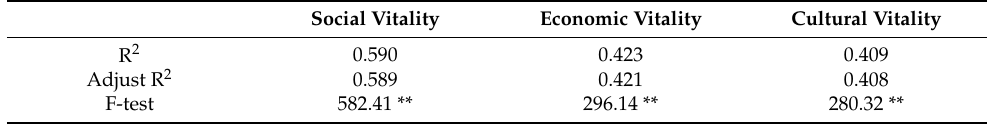
Table 5. Summary result of model for social, economic and cultural vitality.